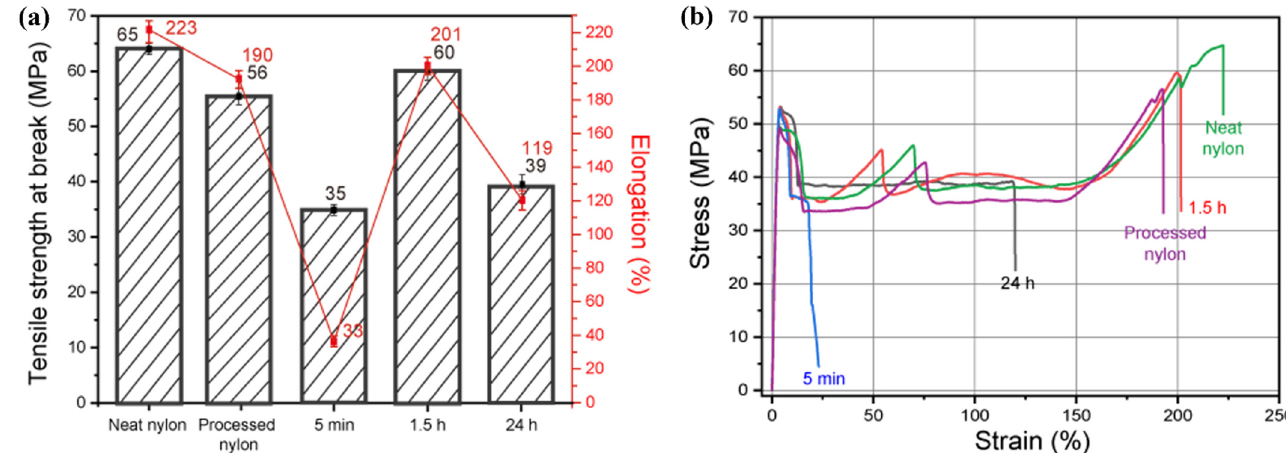
Figure 4. Mechanical properties resulting from various stirring and acid exposure times for the nylon/CSW nanocomposite. ( a ) Elongation (red line) and ultimate tensile strength (black column) and ( b ) stress–strain curve.